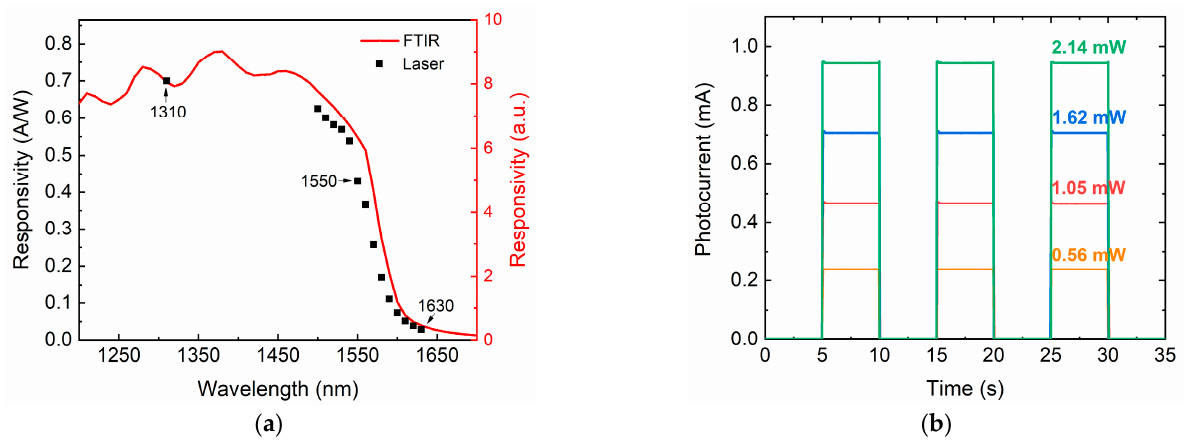
Figure 8. ( a ) The spectral response of GOI photodetectors between 1200 and 1700 nm, and ( b ) time-resolved photocurrent of the GOI photodetector at a wavelength of 1550 nm.